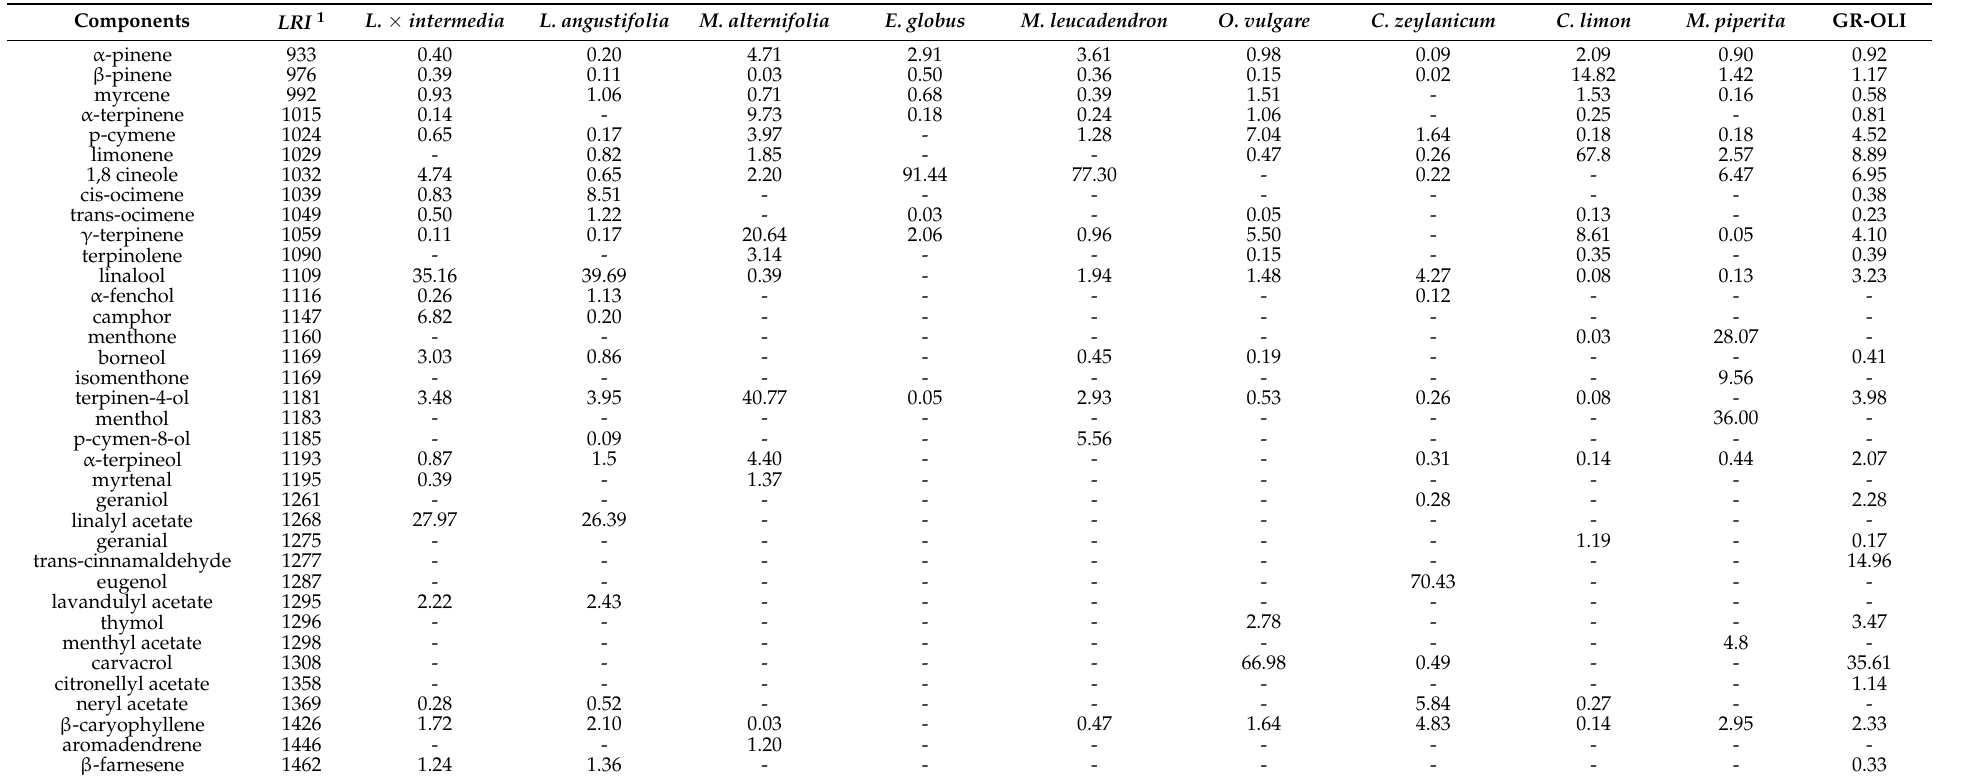
Table 2. Relative percentages of abundance of the most representative mono and sesquiterpenes of the essential oils. The whole chemical composition is displayed in Table S1 of the Supplementary